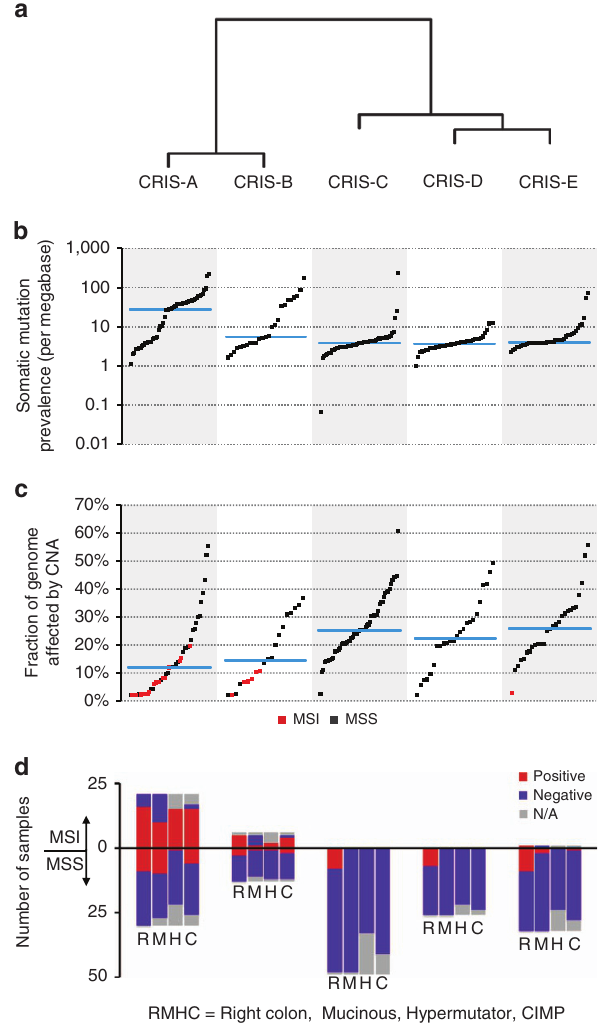
RMHC = Right colon, Mucinous, Hypermutator, Figure 3 | Molecular and phenotypic characteristics of CRIS subtypes in the TCGA data set. ( a ) Clustering of CRIS classes based on similarity of the distances, as calculated by NTP, when classifying the TCGA data set. ( b ) Frequency of somatic single-nucleotide variations. Individual samples are represented as black dots; the mean of each CRIS subtype is plotted in light blue. ( c ) Extent of somatic copy number alterations. Samples are represented as red or black dots to denote MSI or MSS tumours, respectively; the mean of each CRIS subtype is plotted in light blue. ( d ) Distribution of the indicated phenotypic and genetic characteristics of CRC samples across CRIS